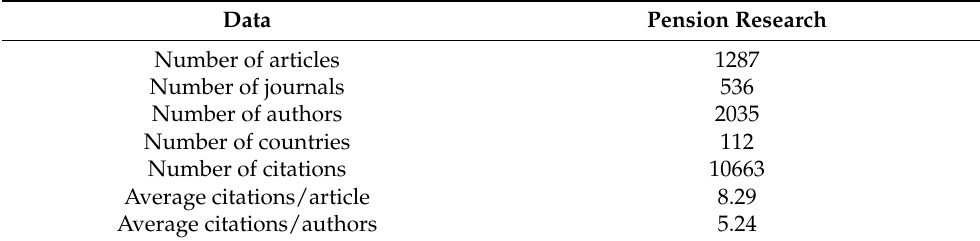
Table 1. Summary of data on pension